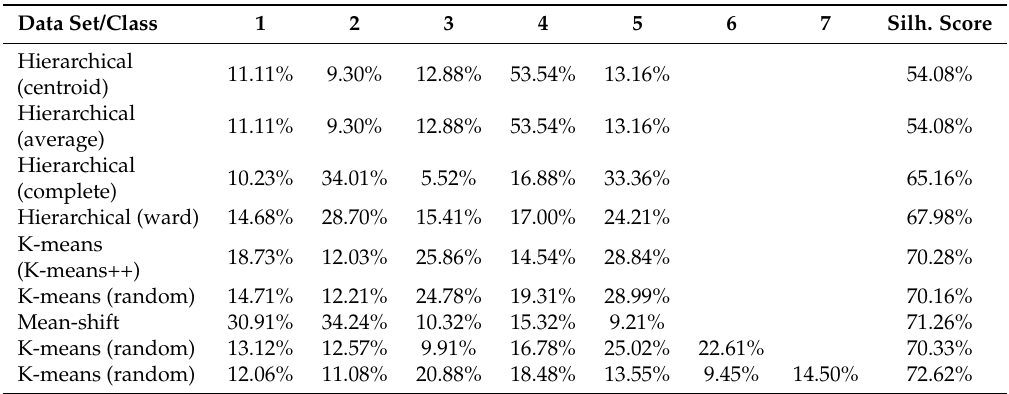
Table 4. Number of pixels (%) for each class for K-means, hierarchical and mean-shift clustering and silhouette score.